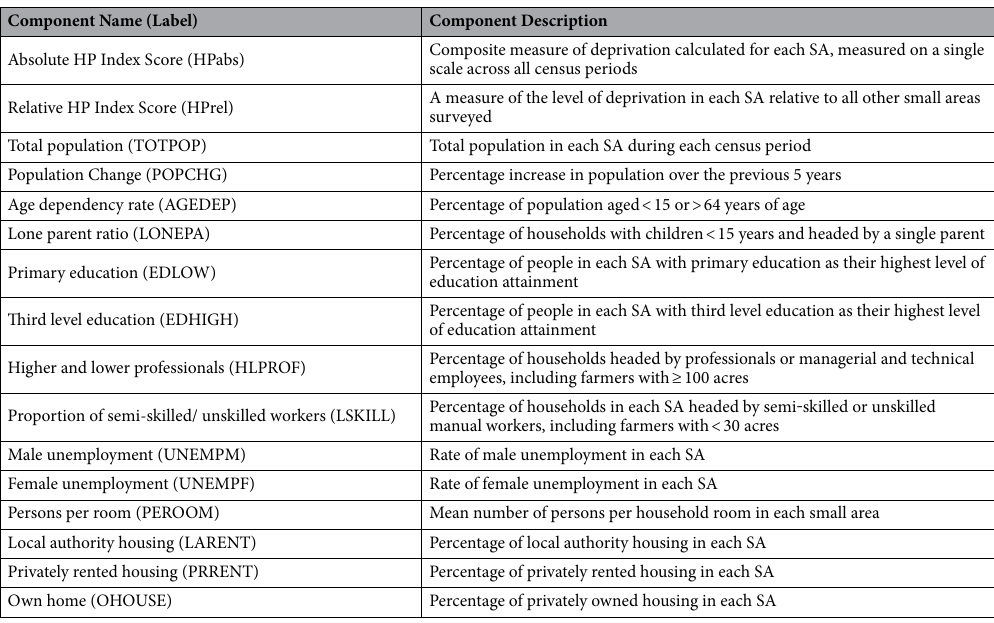
Table 1. Pobal HP deprivation index components and